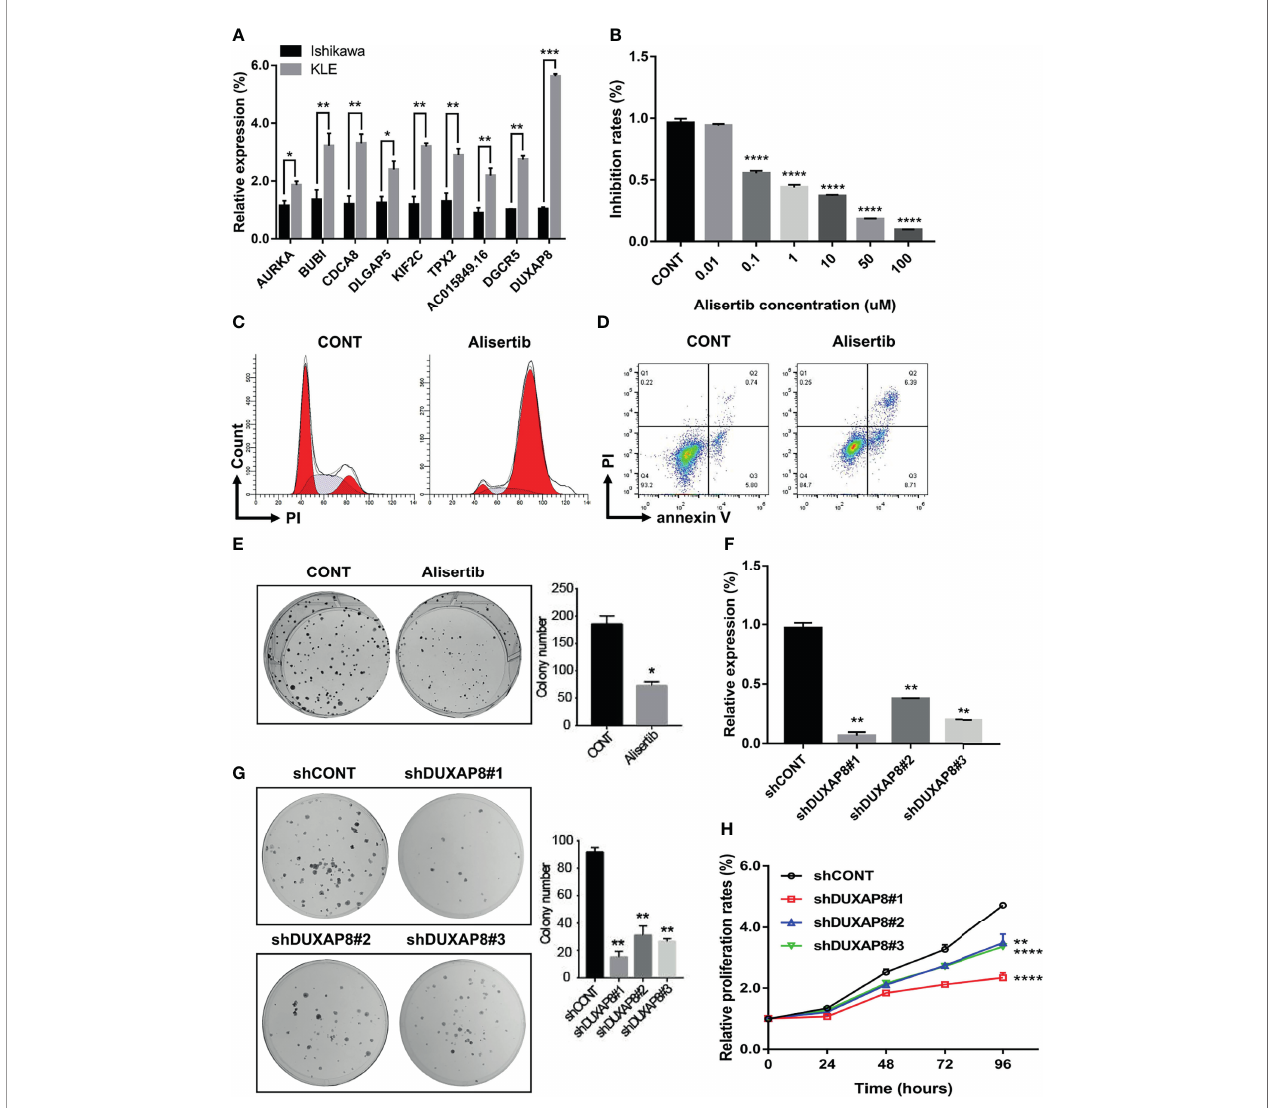
FIGURE 10 | Expression and functional validation of the selected hub mRNAs and lncRNAs in vitro . (A) The expression patterns of these genes in two endometrial cancer cell lines, including Ishikawa (histological grade 1; G1) and KLE (histological grade 3; G3). (B – E) The biological impacts of suppressing AURKA with Alisertib (MLN8237) in UCEC cells in vitro . Alisertib decreased Ishikawa cells viability in a dose-dependent manner, induced G2/M phase arrest and enhanced cellular apoptosis. Furthermore, Alisertib limited the long-term clonogenic survival (1 m M). (F) DUXAP8-shRNA/GFP lenti-virus ( versus control virus) was used to knock down DUXAP8. (G, H) Downregulation of DUXAP8 inhibited the colony formation and impaired cells growth. Data are the mean ± SD of three independent experiments. *P < 0.05, **P < 0.01, ***P < 0.001, ****P <